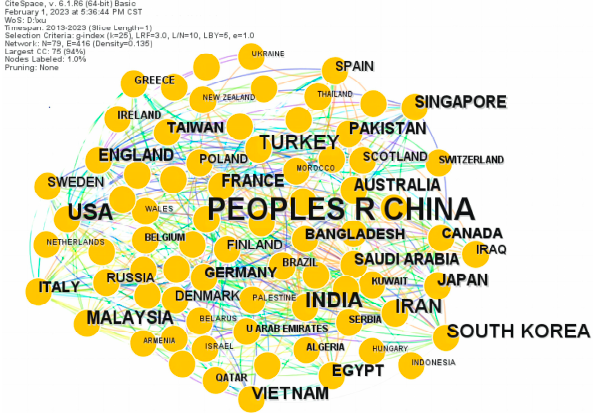
Figure 2. The collaborative network map of country. Table 1. High-frequency country in the research area of metamaterial absorber.